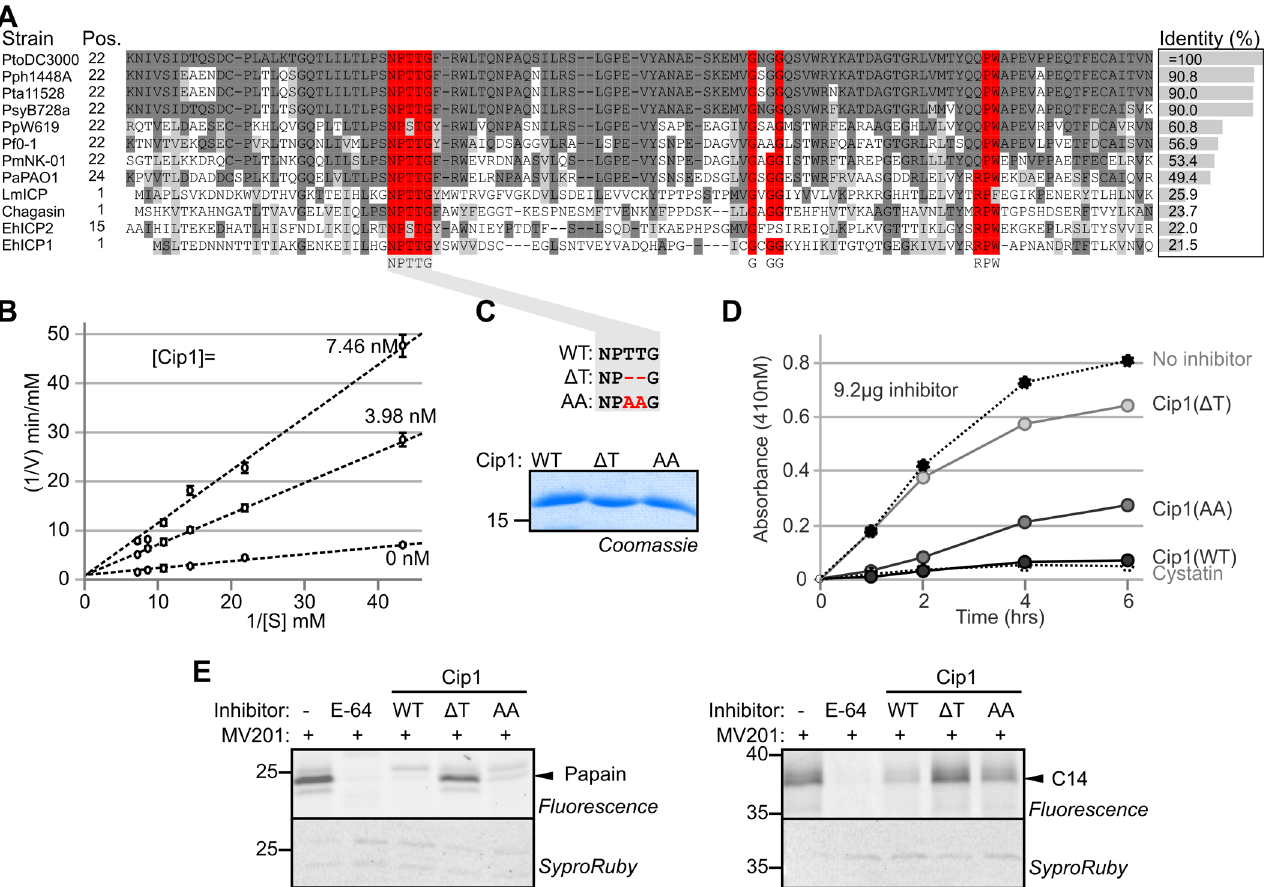
Fig 7. Cip1 is a Chagasin-like protease inhibitor. (A) Alignment of chagasins showing conserved chagasin motifs NPTTG, GxGG and RPW (red). Amino acid identity with Cip1 is shown next to each of the protein sequences. (B) Cip1 is a competitive inhibitor of papain. Papain was incubated without or with 7.46 or 3.98 nM Cip1 and assayed at increasing substrate concentrations. Fluorescence values were plotted against the inverse velocity (V) and inverse substrate concentration [S] in a Lineweaver- Burk plot. K i = 3.98 nM. (C) Cip1 mutant proteins are soluble and stable. The NPTTG motif was mutated by removing the two threonines ( Δ T) or replacing them by alanines (AA). Mutant and wild-type (WT) Cip1 proteins were expressed in E . coli as His-FLAG-tagged protein, purified, separated on SDS-PAGE and stained by coomassie. (D) Mutagenesis of the NPTTG motif affects inhibition of papain. 4.1 μ M papain was incubated with 0.56 μ M (mutant) Cip1 inhibitor or chicken cystatin and 0.2 mM BAPNA. Substrate conversion was monitored by increased fluorescence at 410 nm over time. (E) Protease activity profiling of papain (left) and C14 (right) in the presence of (mutant) Cip1 using pure papain or apoplastic fluids from leaves overexpressing C14 were preincubated with 100 μ M E-64 or (mutant) Cip1 for 30 minutes, and then labeled with 1 μ M MV201 for 1